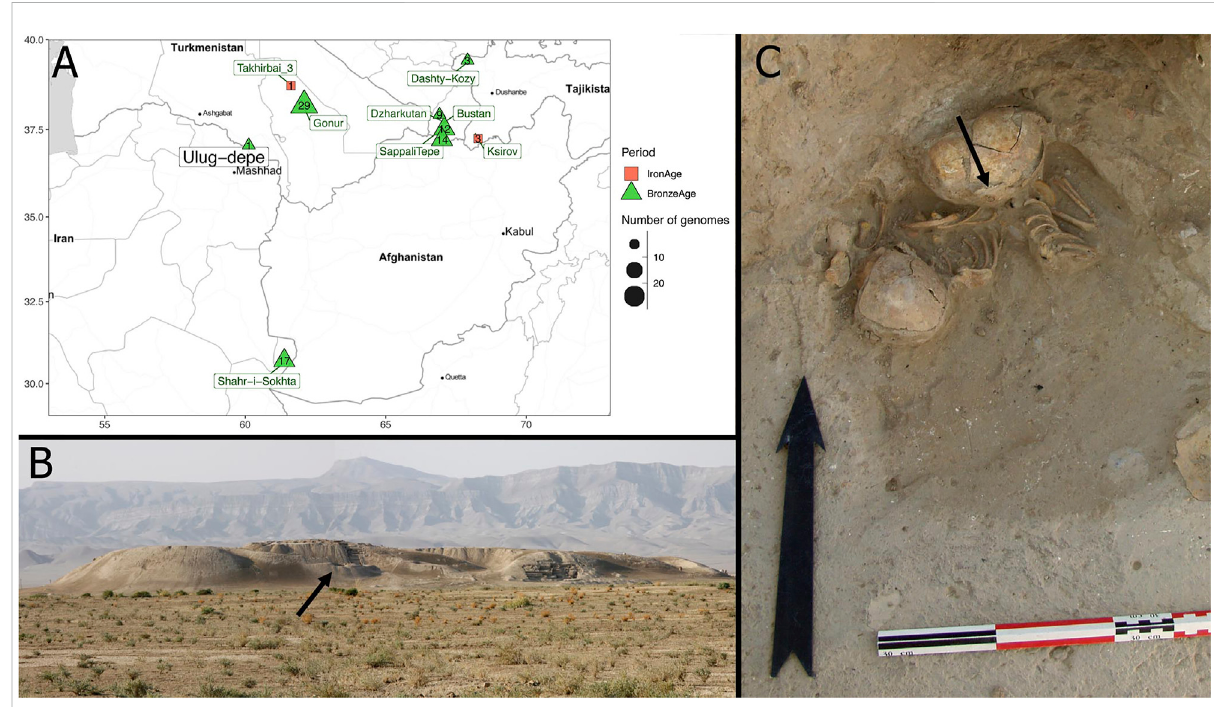
FIGURE 1 The archaeological context of ULG75 . (A) Maps showing the different Turan Bronze Age (green) and Iron Age (red) sites from which genome- widedatawereobtained. (B) ViewfromUlug-depesitefromNorth-East.Theplacewhere ULG75 wasfoundisindicatedbyanarrow. (C) Photograph of the ULG75 burial (grave 75). An arrow indicates the sample from which DNA was